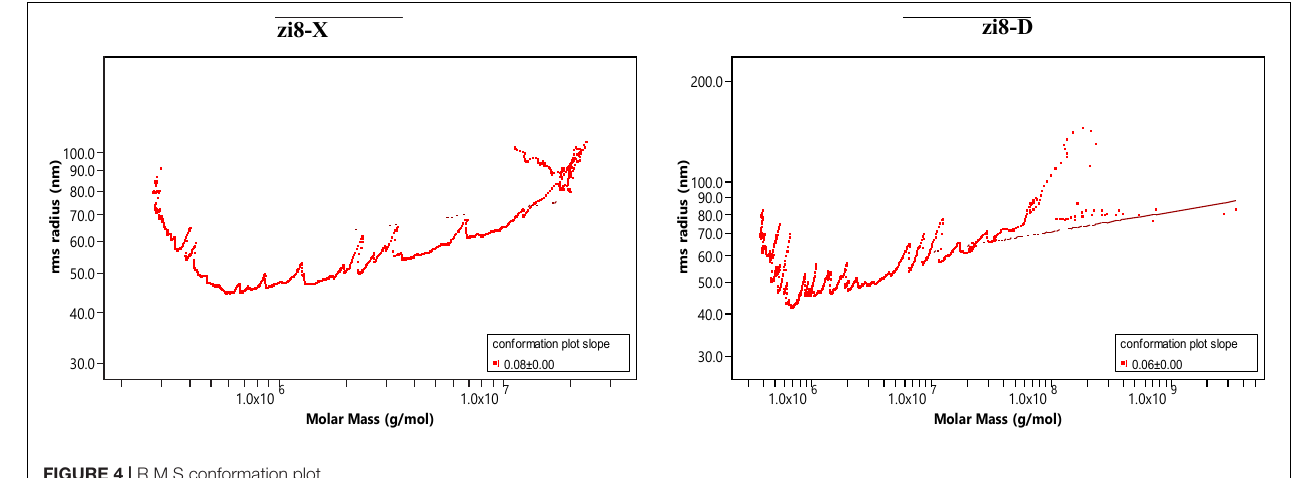
FIGURE 4 | R.M.S conformation